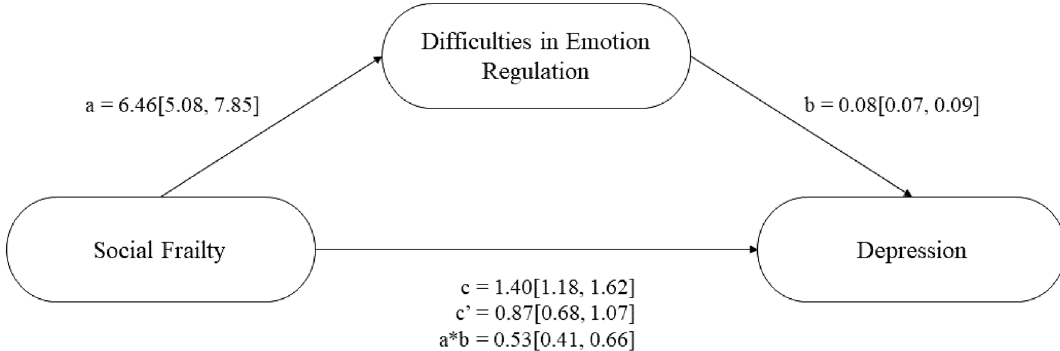
Figure 3. Difficulties in emotion regulation as a partial mediator between social frailty and depression.